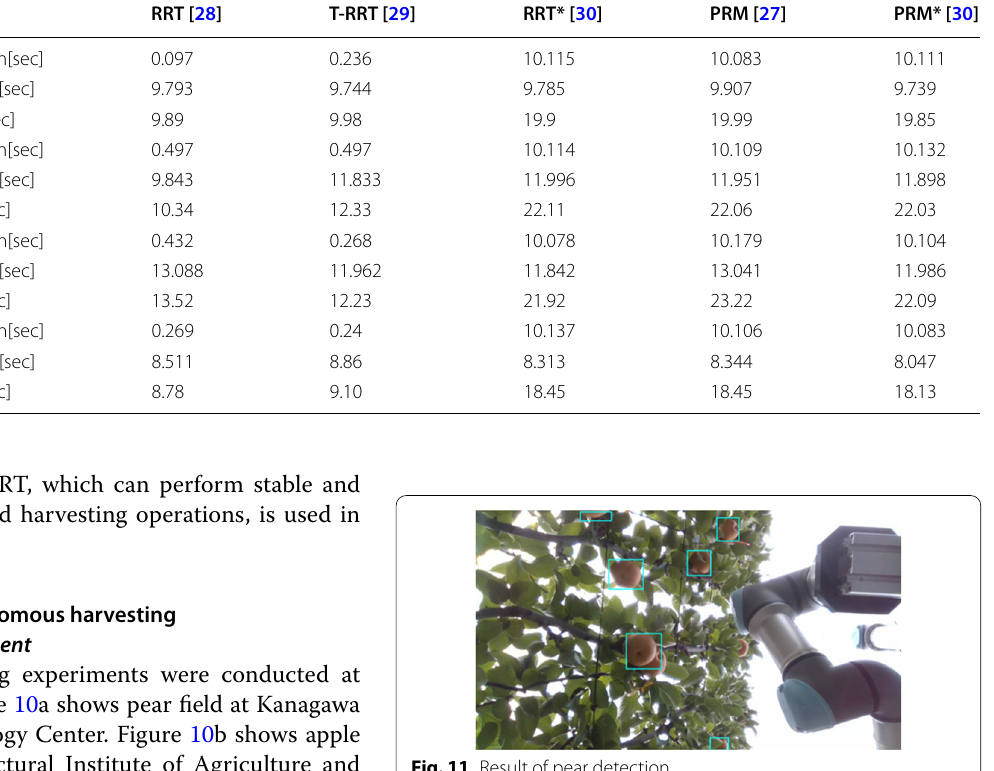
Fig. 11 Result of pear detection